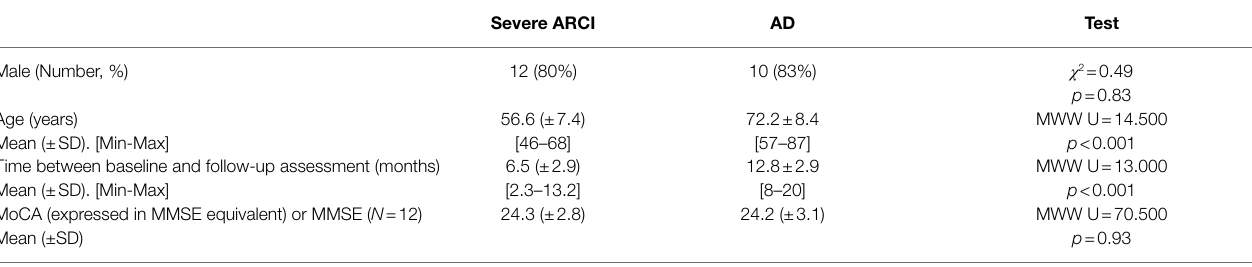
TABLE 2 | Demographic and cognitive assessments characteristics in severe alcohol-related cognitive impairment (severe ARCI) group and Alzheimer’s disease (AD) group. Severe ARCI AD